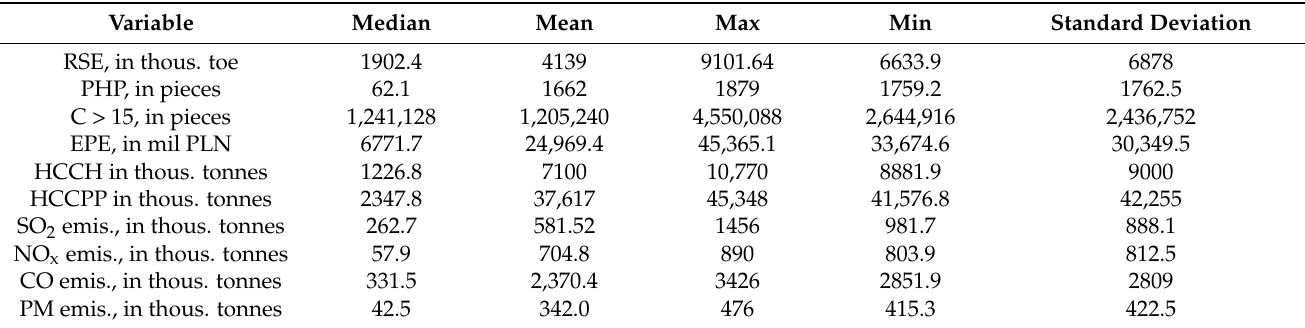
Table 1. Statistical description of the variables.